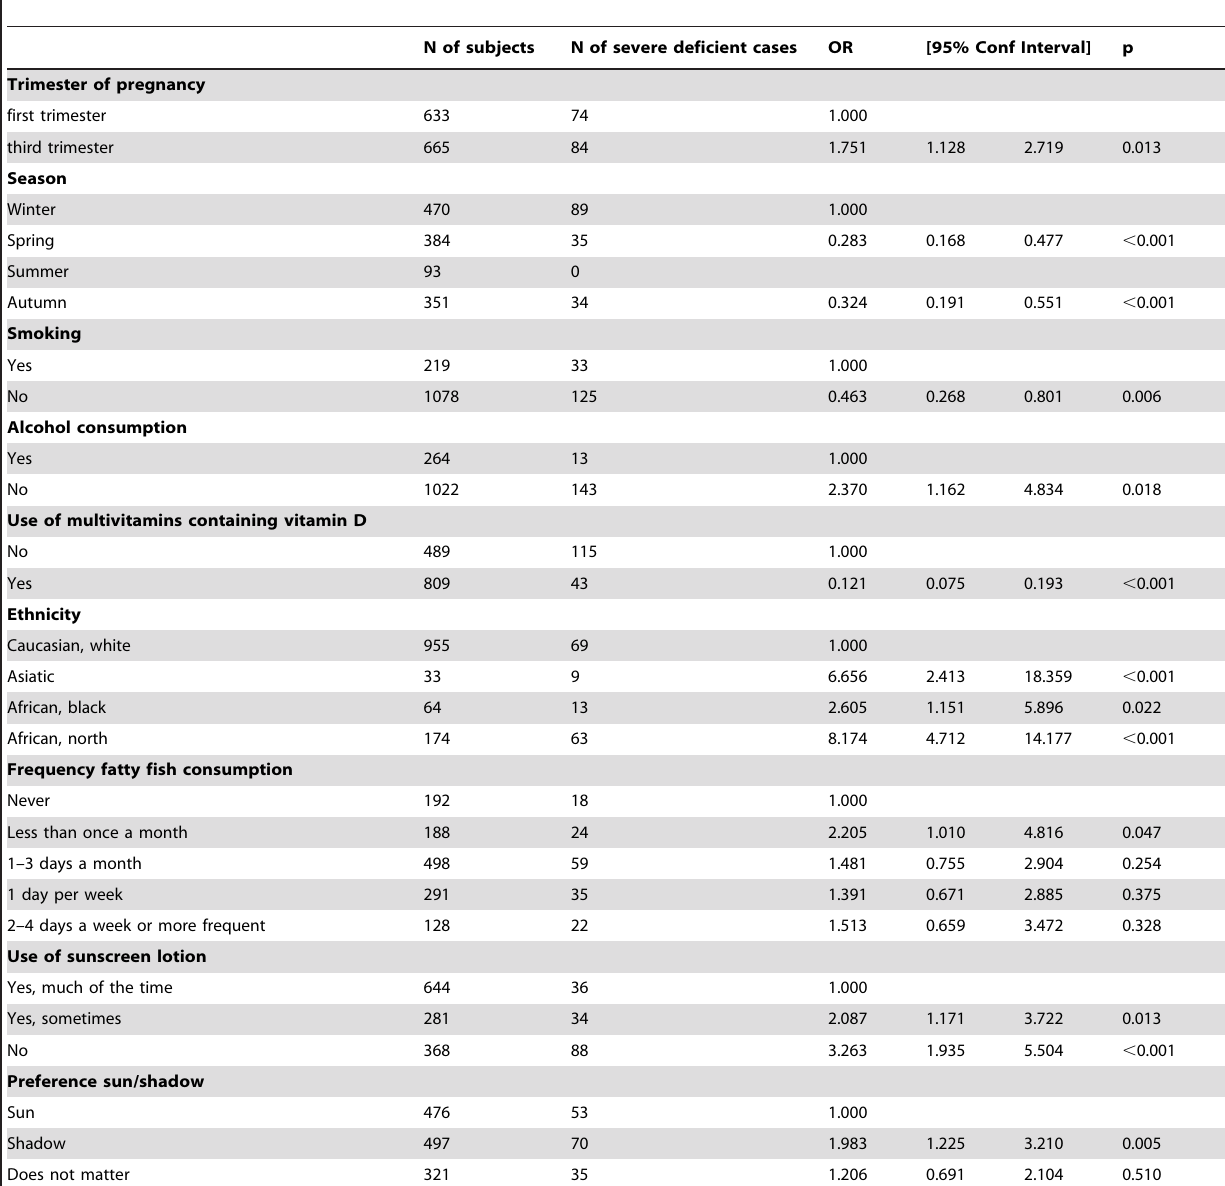
Table 5. Risk of severe vitamin D deficiency during pregnancy in Belgium (25-(OH)D , 10 ng/ml) (n=1121), results of multiple logistic